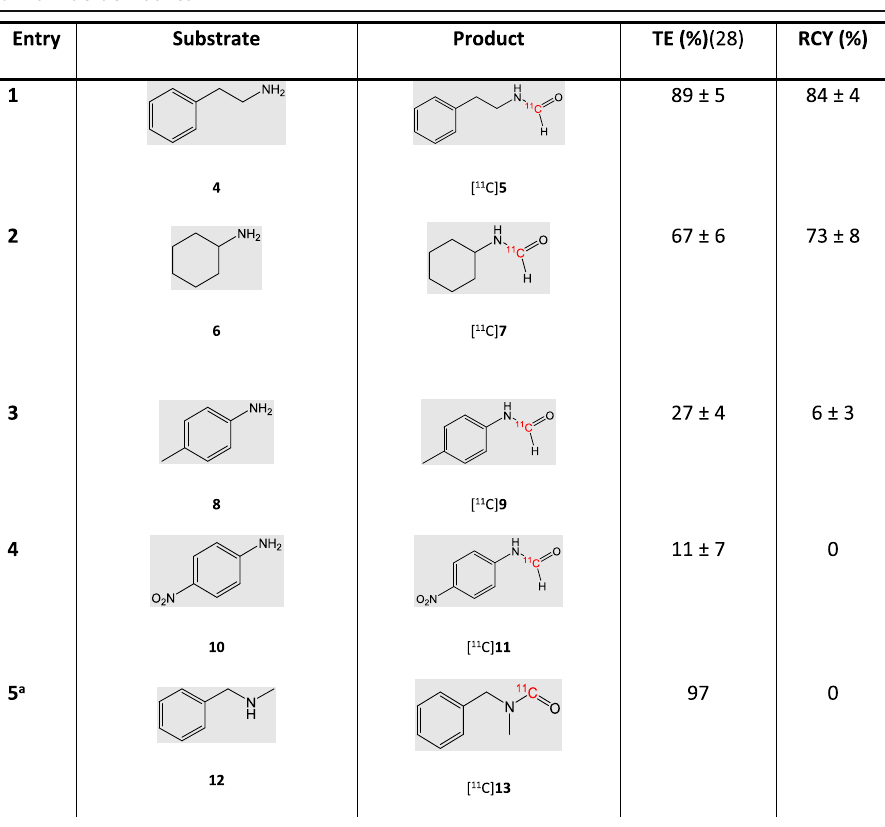
Table 2 Conversion of aliphatic and aromatic amines to their corresponding [ carbonyl - 11